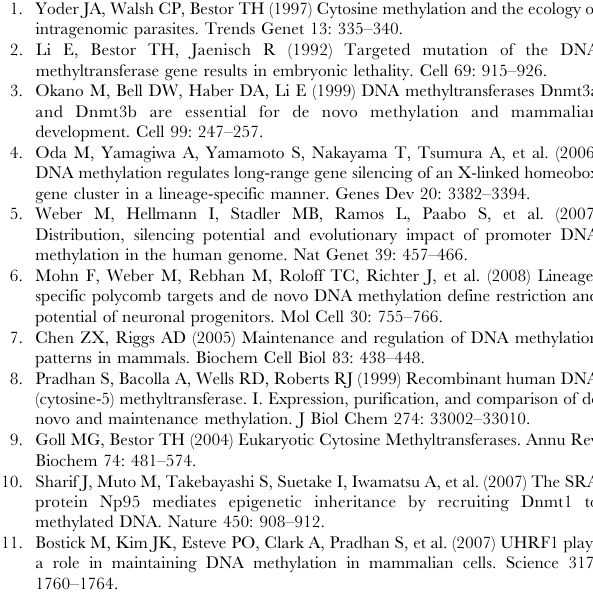
complex with DNMT3L, as measured by bisulfite methylation sequencing. Symbols are as described above. B. The in vitro flanking sequence preference for DNMT3A was determined by focusing on the 10% most and least methylated sites observed in panel A. Both top and bottom sites show evidence of selection for particular residues at the 2 2 position, as was observed in vivo . Figure S4 In vivo methylation patterns observed on the bottom strand of the pBR322 region upon expression of DNMT3A (left) or DNMT3A and DNMT3L (right). The arrows highlight the two most distinct sites in terms of their methylation efficiencies for DNMT3A. Figure S5 DNMT3L promotes the formation of more uniform DNA methylation patterns. The y-axis describes the overall range of methylation efficiencies observed among 48 different CpG sites on the pBR322 bottom strand. In all cases, the least methy- lated site within a sample is given an arbitrary value of 1. The whisker plot (box area comprises 75% of all values) shows that DNMT3L significantly reduces the spread in methylation efficiencies (***, pvalue , 0.001 according to unpaired t-test). Found at: doi:10.1371/journal.pgen.1001106.s005 (1.28 MB EPS) Text S1 Sequence files for analyzed regions. Found at: doi:10.1371/journal.pgen.1001106.s006 (0.03